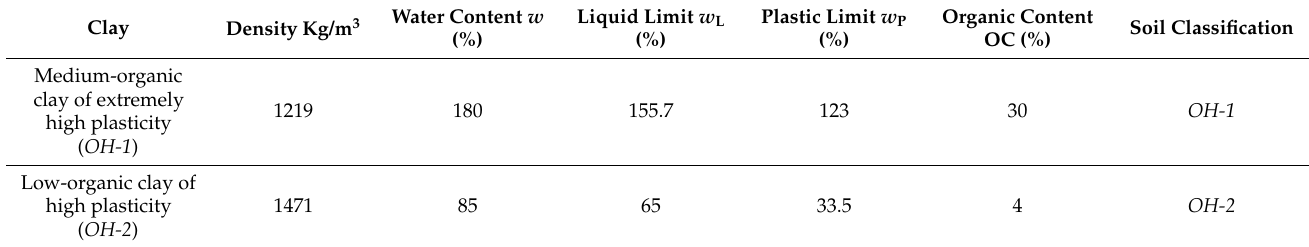
Table 1. Index properties of the two types of organic clays used for